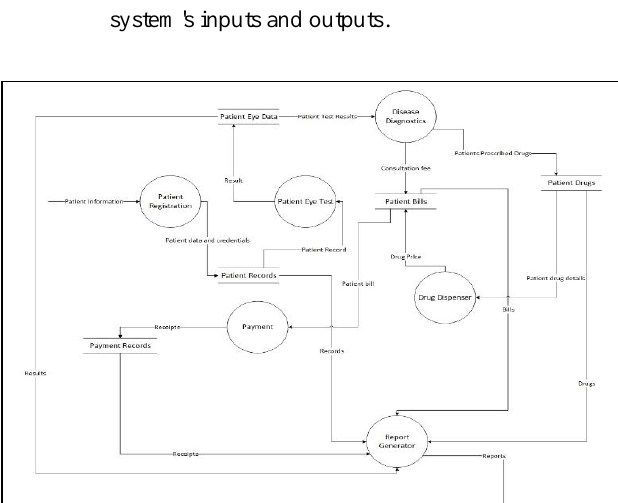
Figure 14. Data Flow